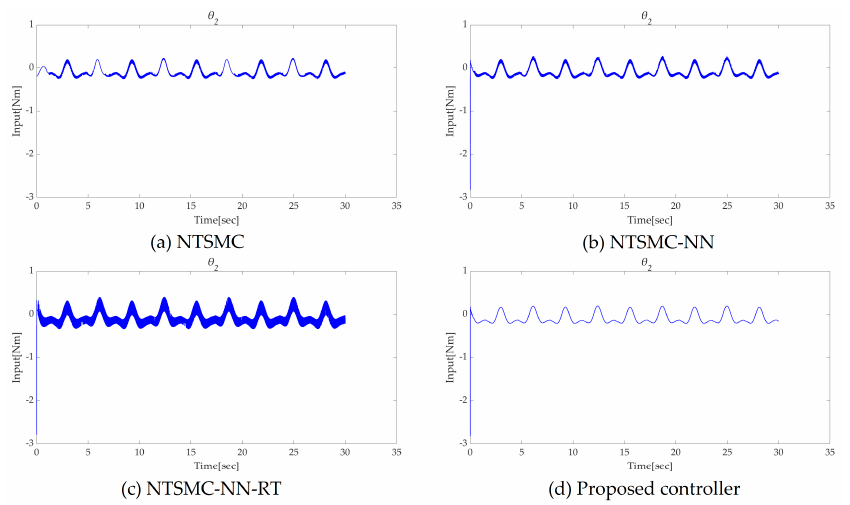
Figure 13. Continuous input control input θ 2 control performance. ( a ) NTSMC input result; ( b ) NTSMC-NN input result; ( c ) NTSMC-NN-RT input result; ( d ) proposed controller input result.